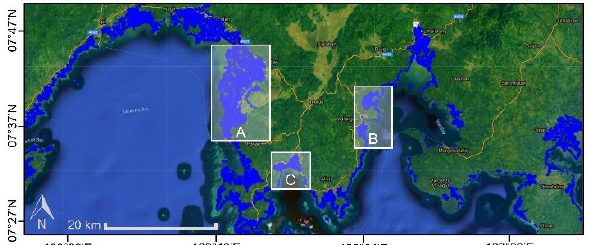
Figure 16 . Sites with varying thresholds in tile 51NVJ: (A) near Sibuguey Bay, (B) near Igat Bay, and (C) near Tantanang Bay. The blue pixels are classified as mangroves in the MVI-based 2019 Mangrove Extent Map of the Philippines. The computed areas of mangrove cover in these sites using the original and optimal site-specific thresholds are summarized in Table 2.